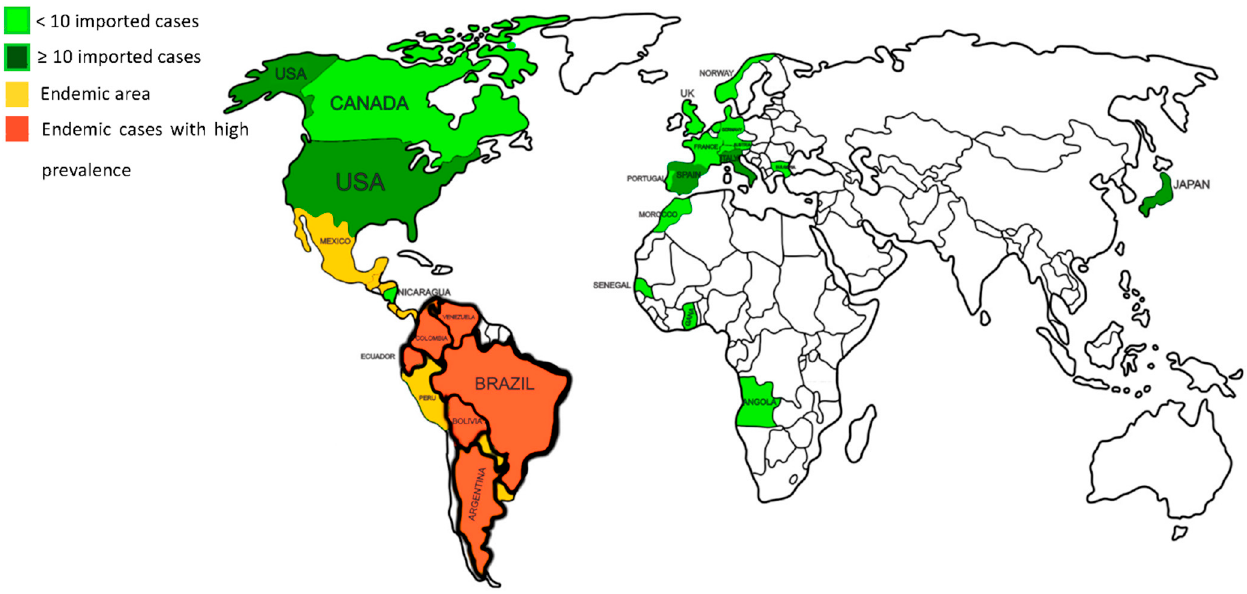
Figure 1. Geographic distribution of Paracoccidioidomycosis in relation to endemic areas and imported cases.